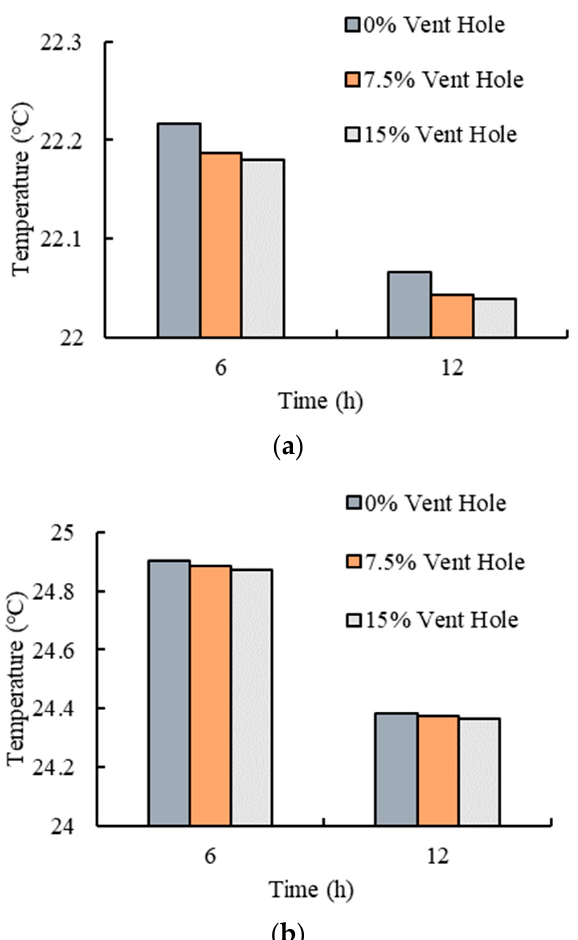
Figure 13. Temperature variations of the fresh tea leaves with different vent hole areas: ( a ) average temperature; and ( b ) maximum temperature.